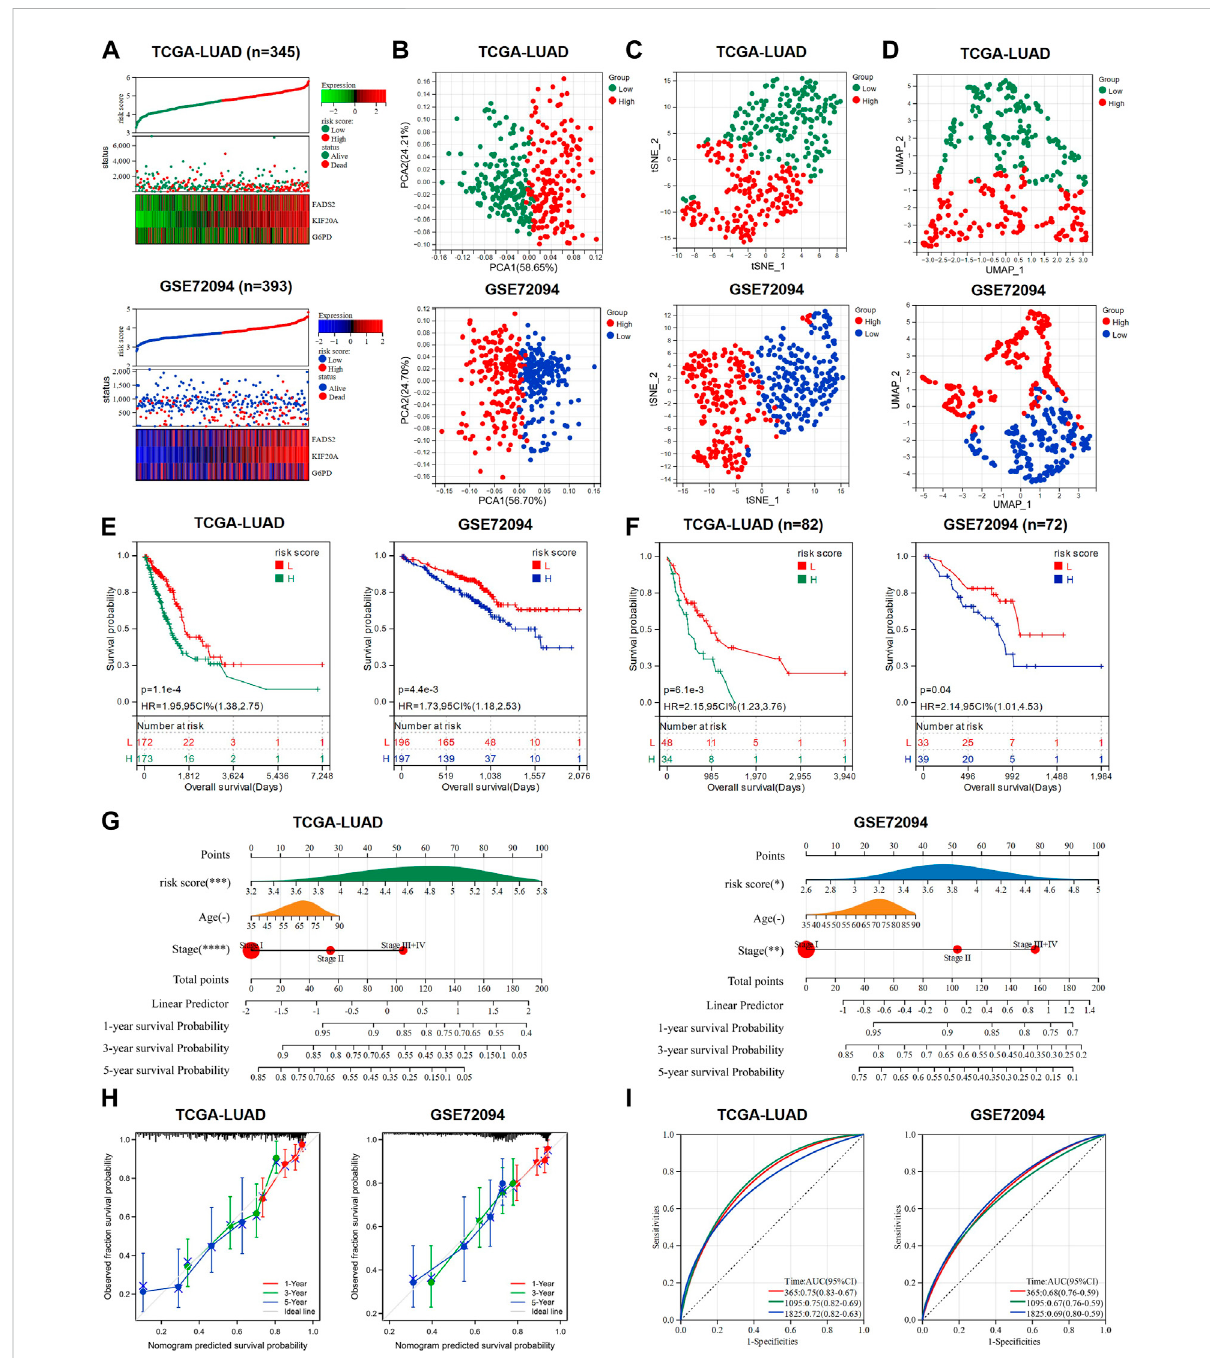
FIGURE 2 A prognostic model to predict the survival of LUAD patients was constructed and validated. (A) Expression heat map of the three candidate genes,riskscorecurveandsurvivalstatusscatterplotforeachLUADpatientintrainingcohortandvalidationcohort,respectively. (B – D) PCAanalysis, t-SNE analysis and UMAP analysis were used to verify the grouping performance of the prognostic model. (E) K-M curves for OS of LUAD patients in the high-risk and low-risk groups. (F) K-M curves for OS of advanced LUAD patients (stage III + IV) in the high-risk and low-risk groups. (G) Nomograms were constructed using three independent prognostic factors (risk score, age, and tumor stage) to predict OS at 1-, 3-and 5-year for LUAD patients. (H) The calibrationplots assess the accuracy of the nomogram. (I) AUC of ROC curves for validating the accuracy of risk model 1-, 3- and 5-year survival predictions. LUAD: lung adenocarcinoma; TCGA: The Cancer Genome Atlas; PCA: principal component analysis; t-SNE: t-distributed Stochastic Neighbor Embedding; UMAP: uniform manifold approximation and projection; K-M analysis: Kaplan-Meier analysis; OS: overall survival; ROC: receiver operating characteristic; AUC: area under the curve; HR: hazard ratio. * p < 0.05; ** p < 0.01; *** p < 0.001; **** p < 0.0001; ns p >